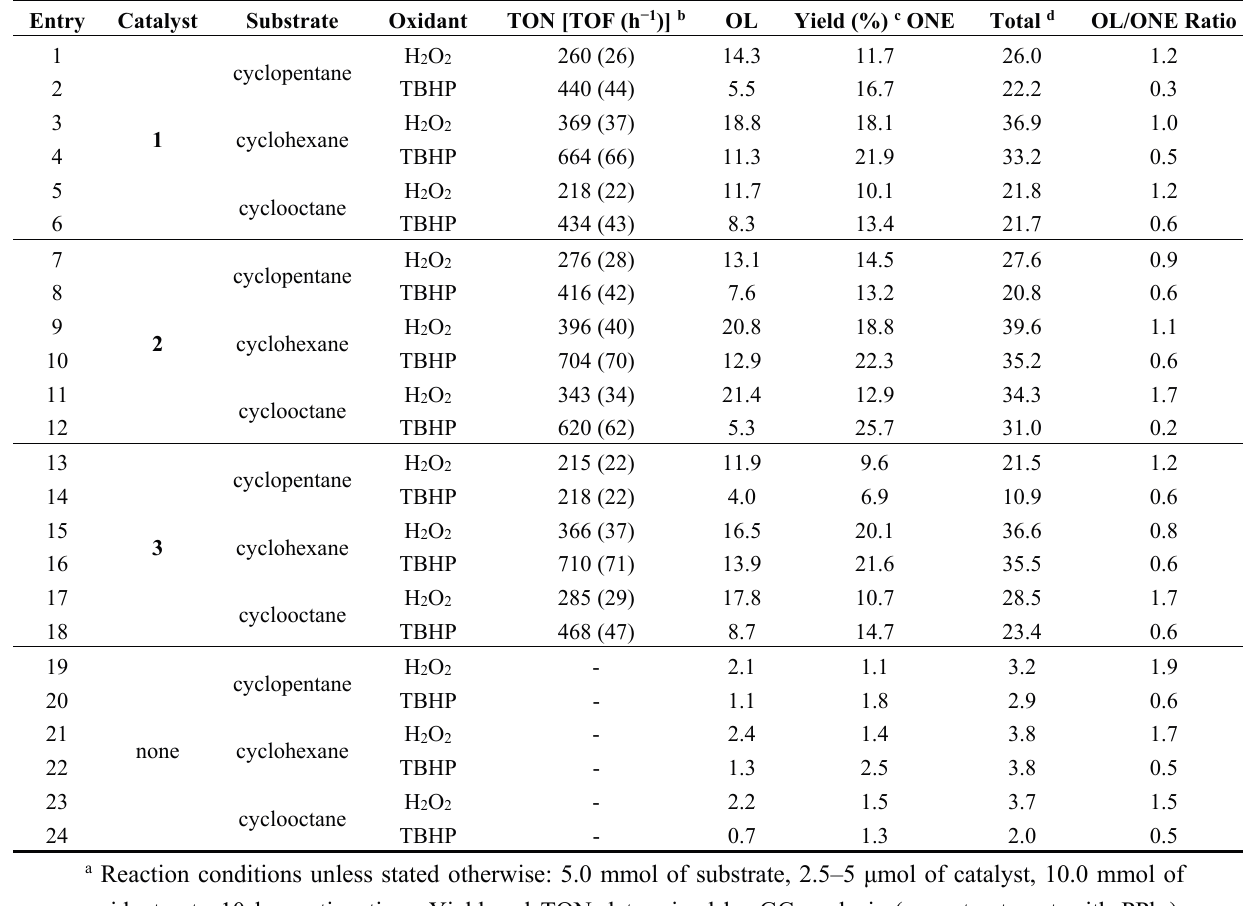
oxidant, r.t., 10 h reaction time. Yield and TON determined by GC analysis (upon treatment with PPh 3 ). b Turnover number = number of moles of products per mol of catalyst; TOF = TON per hour (values in brackets). c Molar yield (%) based on substrate, i.e. , moles of product (alcohol (OL) or ketone (ONE)) per 100 mol of cycloalkane. d Moles of alcohol + ketone per 100 moles of